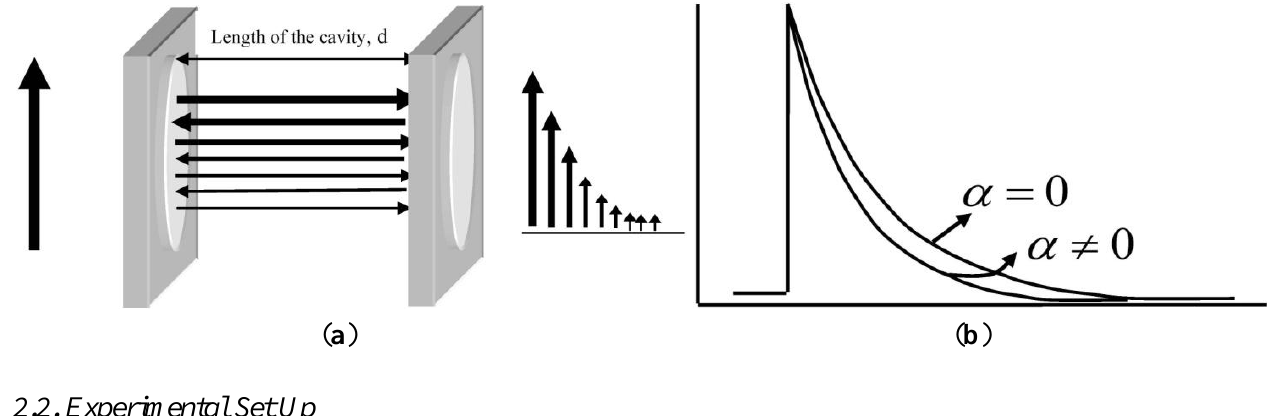
Figure 1. Illustration of the basic CRDS concept. ( a ) Retroflections and the resulting ringdown waveform. ( b ) The induced change in ringdown time as a function of the concentration of the absorbing species present in the beam